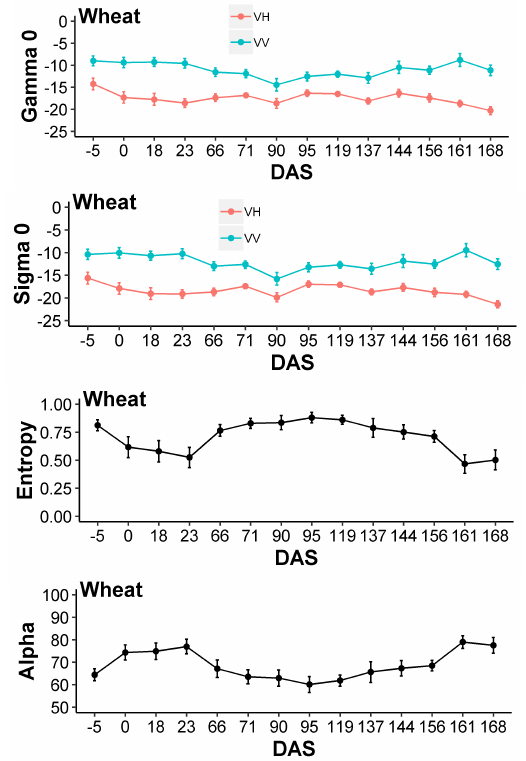
Figure 3. Mean (black line) and standard (error bar) deviation for Sigma, Gamma, Entropy and Alpha angle for wheat